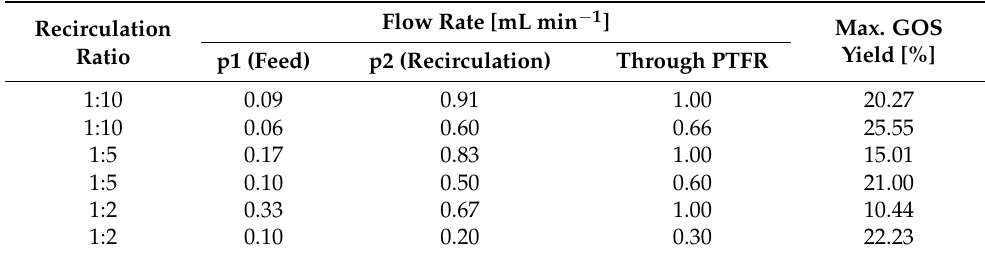
Table 3. Flow settings for the recirculation system (Figure 2d) for GOS synthesis with immobilized β -gal on the 1 mL-PTFR (p =